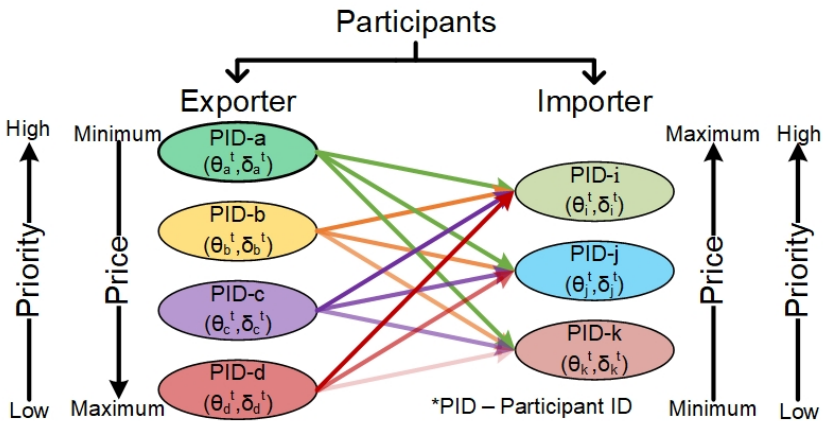
Figure 4. Prioritization of participants by TEMO.